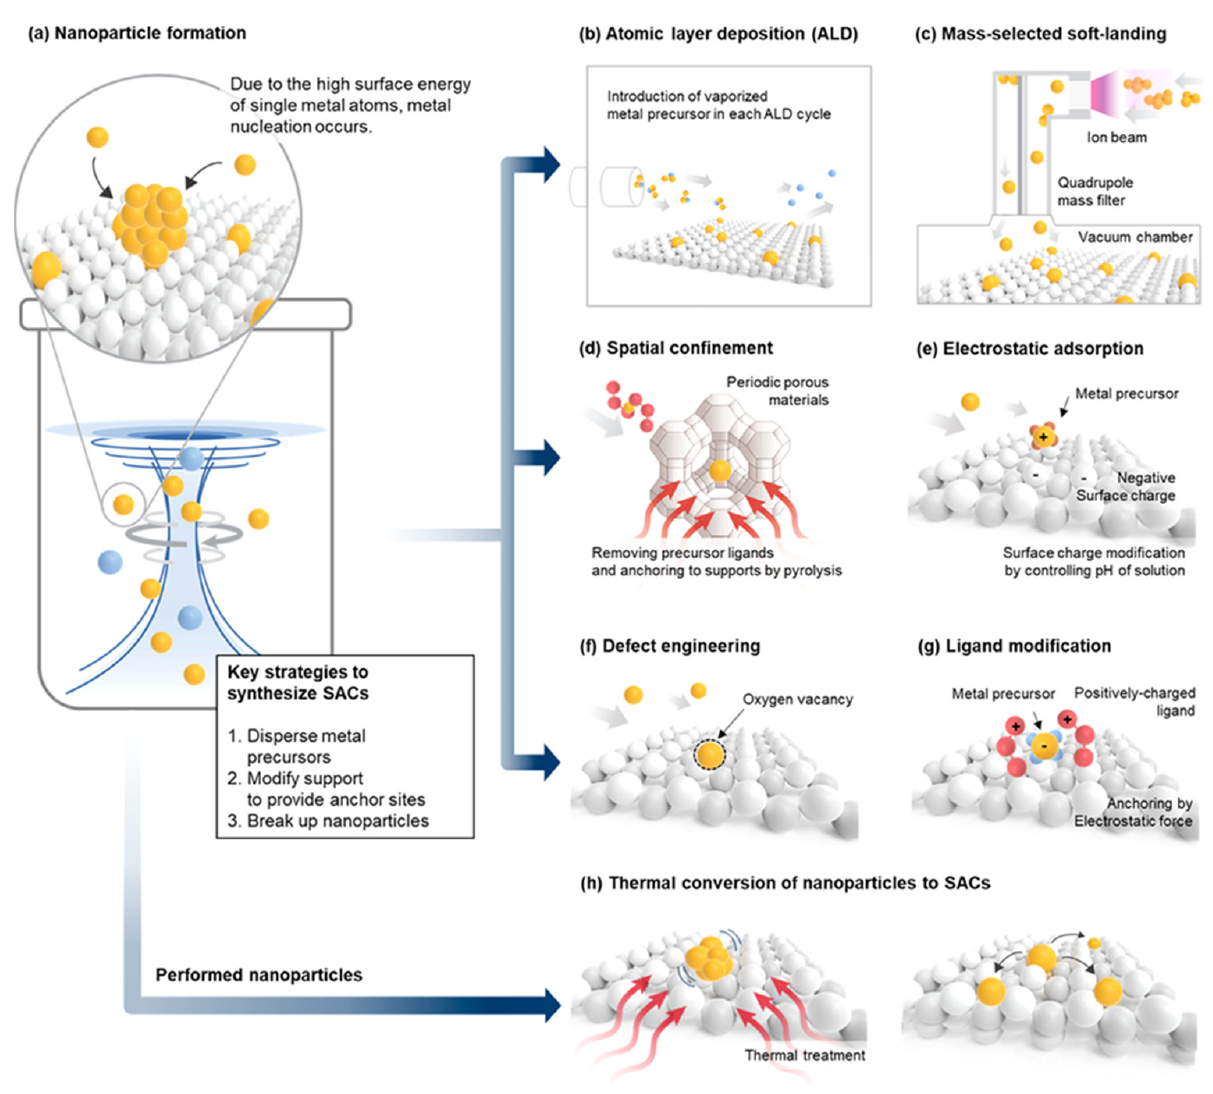
Figure 2. Schematic illustration of single-atom catalysts fabrication methods. Reprinted with permission from Ref [32], Copyright © 2020 American Chemical Society.